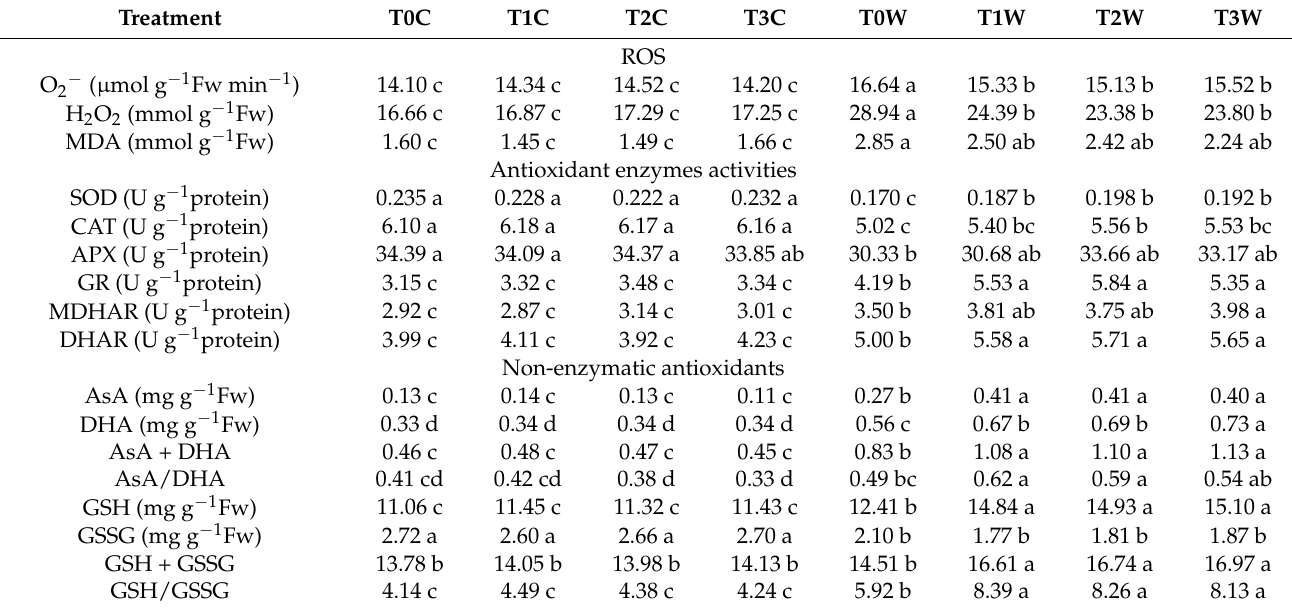
Table 1. Effects of waterlogging priming on function of antioxidant system in root of offspring plants under hypoxia stress in wheat